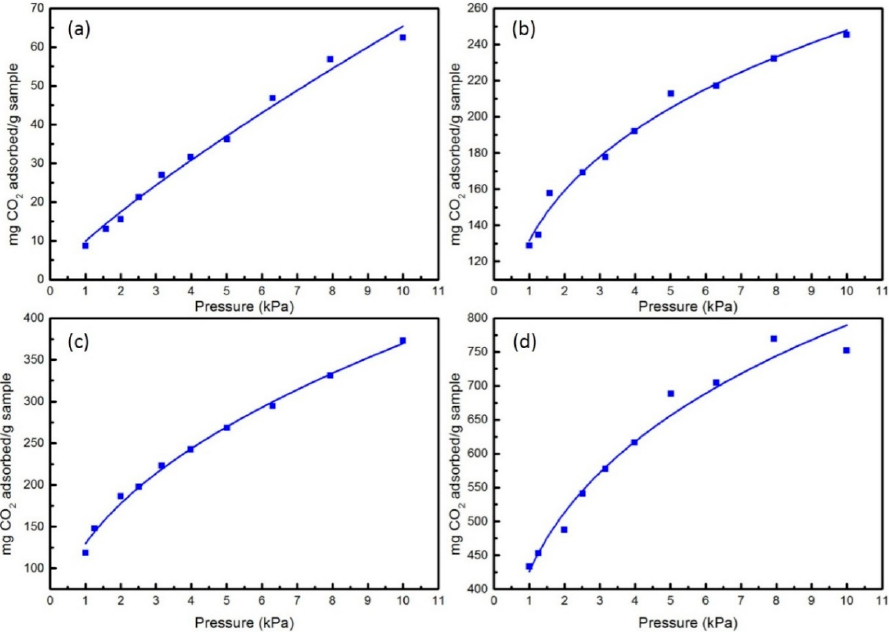
Figure 4. The computed sorption isotherms of CO 2 in ( a ) EB-PANI; ( b ) Na-SPANI (I); ( c ) Na-SPANI (II); ( d ) Na-SPANI (III) at 298 K.